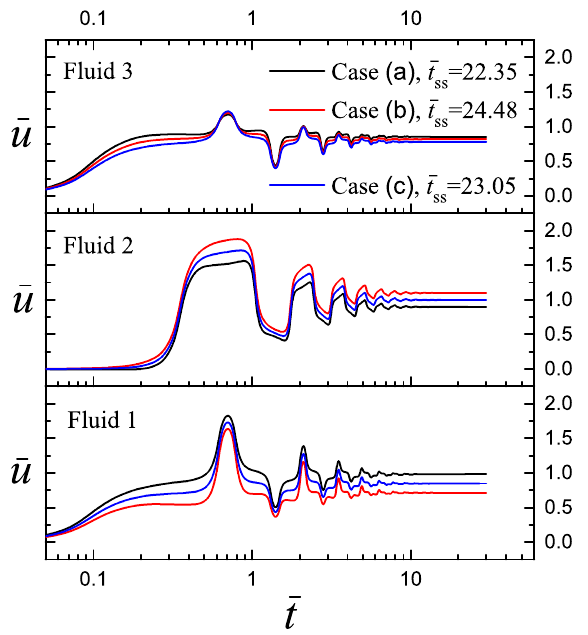
Figure 6. Velocity tracking of an electro-osmotic flow, cases taken from Figure 3. Case ( a ) ∆ ¯ ψ n = 0.25, Case ( b ) ∆ ¯ ψ n = 0, and Case ( c ) ∆ ¯ ψ n = − 0.25 at the middle of each fluid